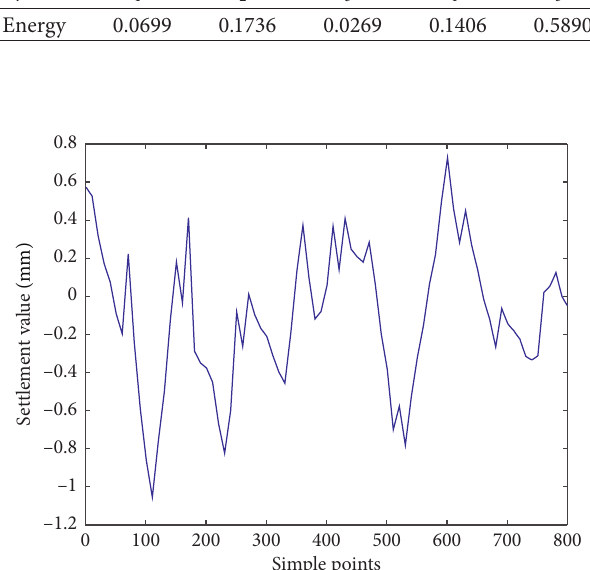
Figure 7: The first four layers’